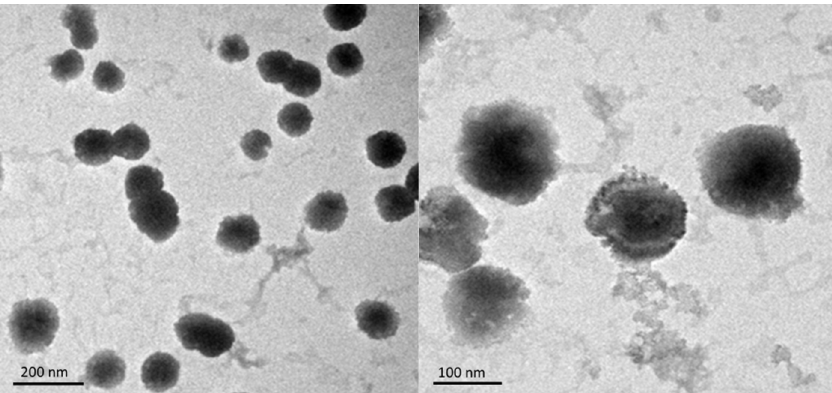
Figure 2. Puerarin chitosan nanoparticles (Pur-CS/TPP-NPs) under transmission electron microscopy.